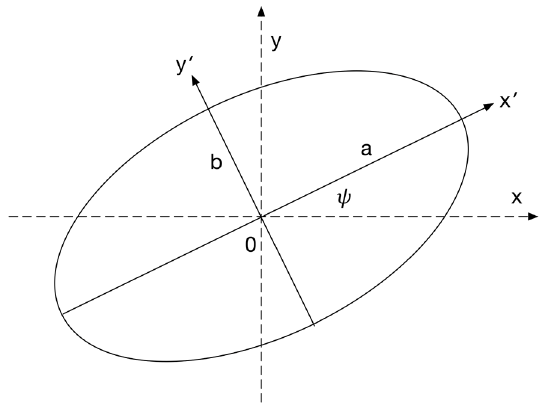
Figure 3. The rotated polarization ellipse [10].